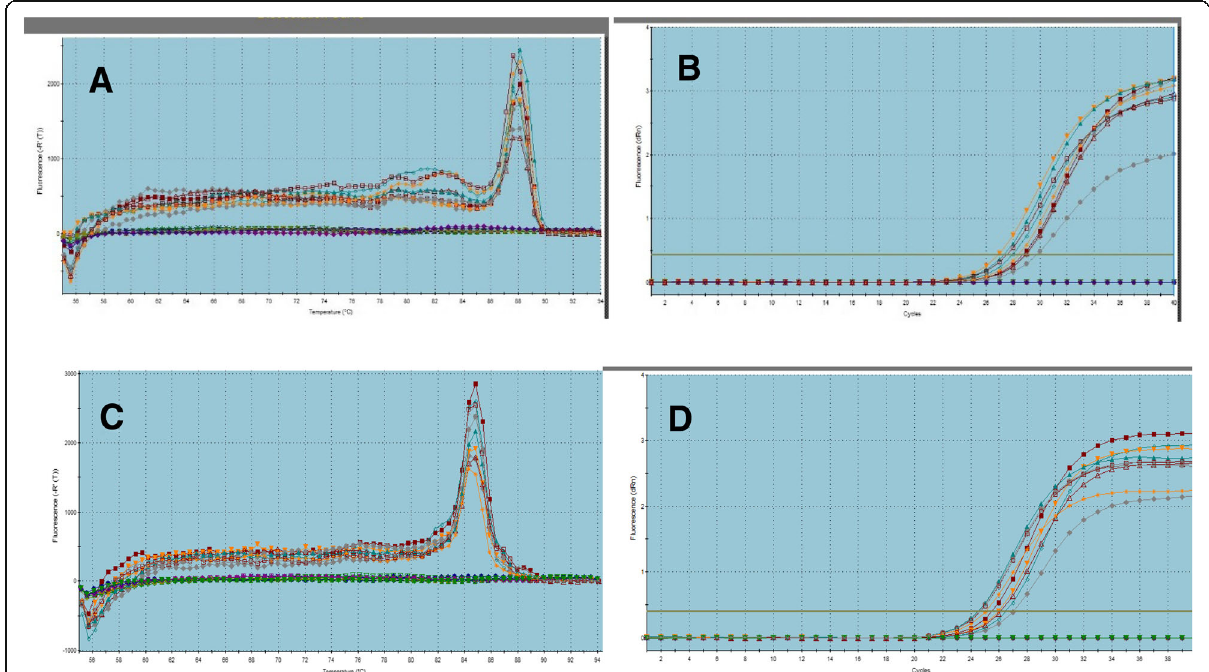
Fig. 2 Melting curve analysis showed a single peak for MT gene ( a ) and β -actin ( c ) gene. Representative amplification plot for MT gene ( b ) and β -actin gene ( d